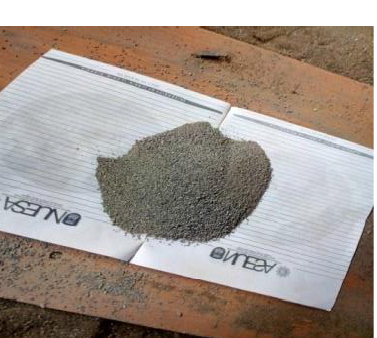
Figure 2a: Sample of periwinkle shell grains (250µm) Figure 2b: Sample of periwinkle shell grains (420µm)